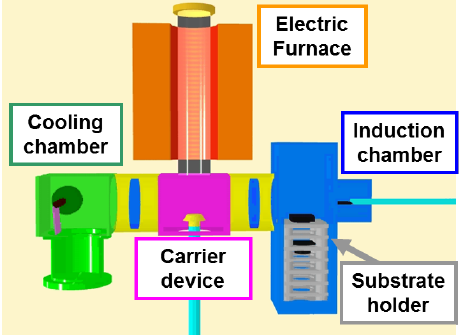
Figure 13. Schematic illustration of the automatic catalytic vapor deposition (CVD)